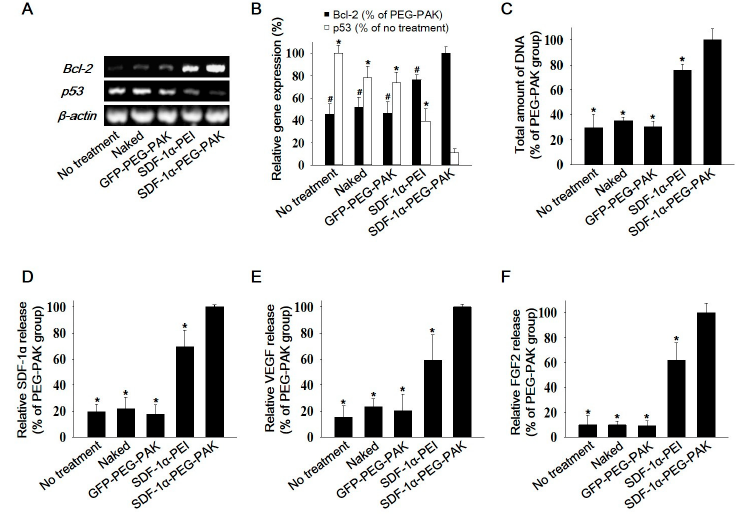
Figure 2. Apoptotic activity and pro-angiogenic growth factor secretion in hADSCs transfected with SDF-1 α using PEG-PAK micelles. ( A ) RT-PCR analysis of the anti-apoptotic factor Bcl-2 and the pro-apoptotic factor p53 and ( B ) quantification of their expression in hADSCs transfected with SDF-1 α using various methods. ( C ) Total amount of DNA in each group showing relative cell viability. Relative levels of ( D ) SDF-1 α , ( E ) VEGF, and ( F ) FGF2 secretion by hADSCs transfected with SDF-1 α using various methods. Secretion was quantified via enzyme-linked immunosorbent assays. (* ,# p < 0.05 compared with SDF-1 α -PEG-PAK group). VEGF: vascular endothelial growth factor; FGF2: basic fibroblast growth factor.